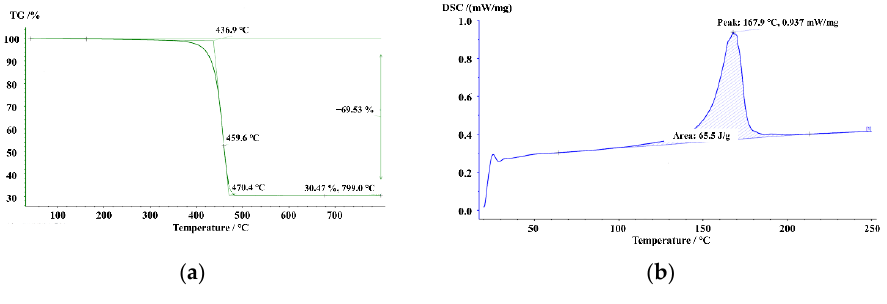
Figure 2. ( a ) TG curve; ( b ) DSC curve.